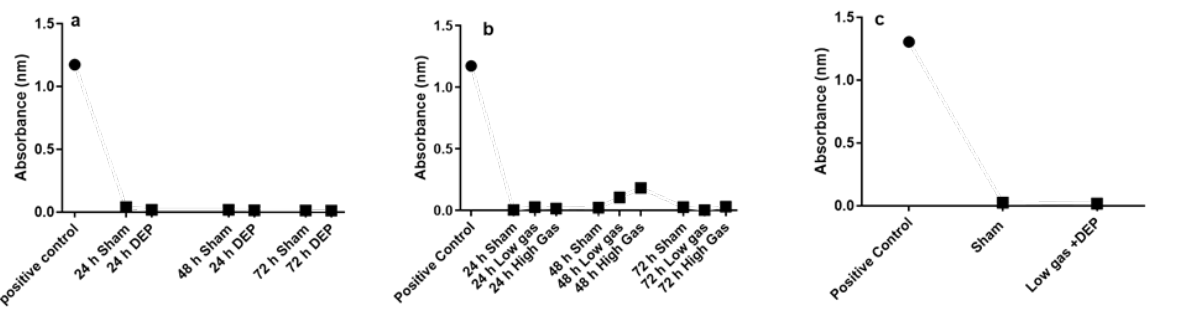
Figure 2. Cytotoxicity following repeated exposure to diesel exhaust particles (DEP: 12.7 µg/cm 2 ; ( a ), low (NO 2 : 0.1 ppm; SO 2 : 0.2 ppm) and high (NO 2 : 0.2 ppm; SO 2 : 0.4 ppm; ( b ) and single combined exposure to DEP and low gas ( c ). The colorimetric lactate dehydrogenase assay used to measure the cytotoxic effect on bronchial mucosa models developed at the air-liquid interface (bro-ALI: N = 3, n = 2/donor) following overnight incubation of every exposure, positive control (kit provided).